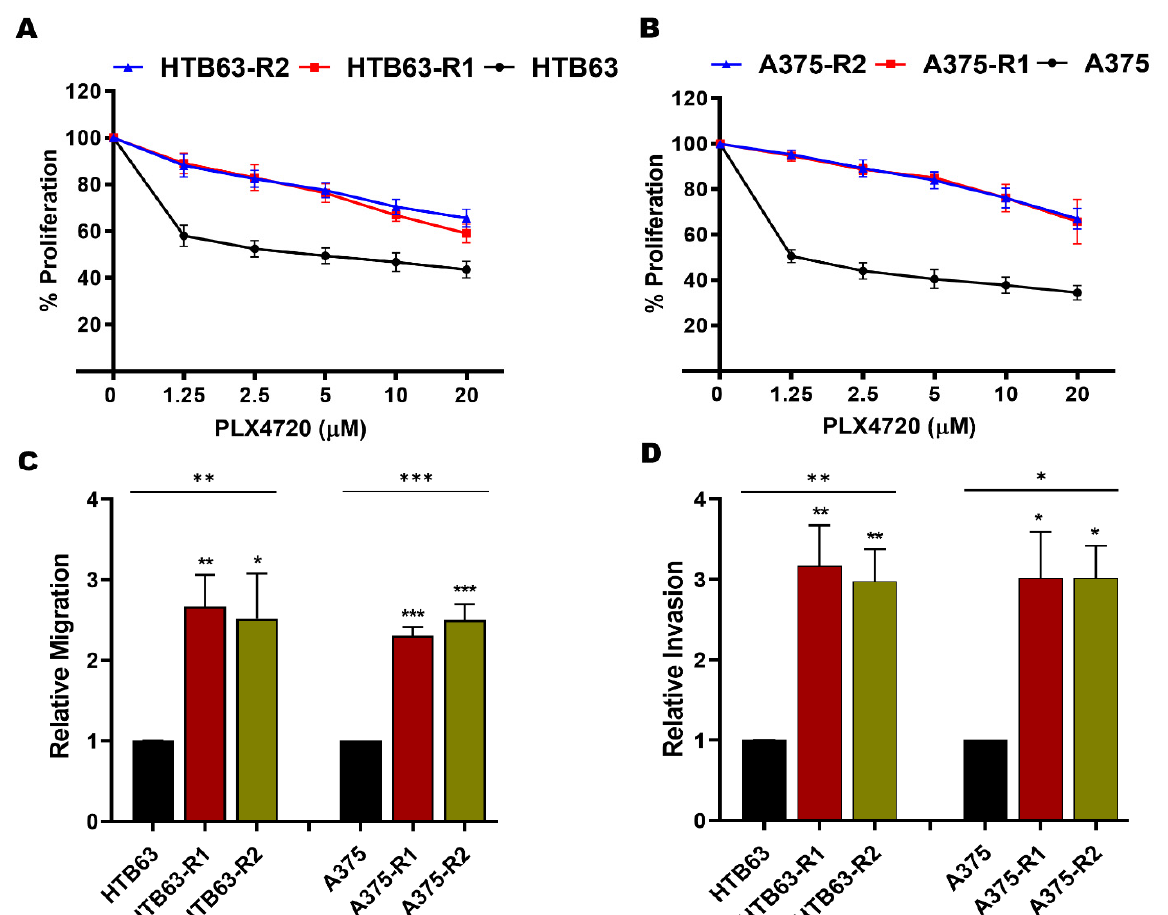
Figure 1. BRAFi-R melanoma cells possess higher IC 50 value and are more aggressive than BRAFi- sensitive melanoma cells. ( A , B ) WST1 cell proliferation assays were performed to evaluate the development of BRAFi resistance to PLX4720 in melanoma cells, as described in Section 2. BRAFi- sensitive (black circle), PLX-4032-R (R1; red square), and PLX-4720-R (R2; blue triangle) cells were exposed to increasing concentrations of BRAF inhibitors for 72 h. Graphs were generated from 4 independent experiments, and values are presented as the means (n = 4) ± SEMs. The IC 50 values for PLX4720 treatment were as follows: 2.5 µM for BRAFi-sensitive A375 cells, 2.5 µM for BRAFi-sensitive HTB63 cells, and >20 µM for A375-R1, A375-R2, HTB63-R1, and HTB63-R2 cells. ( C , D ) transwell-based migration and invasion assays were performed to evaluate the migration ( C ) and invasion ( D ) capacities of BRAFi-sensitive (HTB63 and A375), BRAFi-R1 (HTB63-R1 and A375-R1) and BRAFi-R2 (HTB63-R2 and A375-R2) melanoma cells. The numbers of migrated and invaded cells were determined using NIH ImageJ software, and the values were normalized to those in BRAFi- sensitive melanoma cells and are given as the mean ± SEM of 4 independent experiments. Statistical significance was estimated using ANOVA with Dunnett’s post hoc test for multiple comparisons; * p < 0.05, ** p < 0.01, *** p <